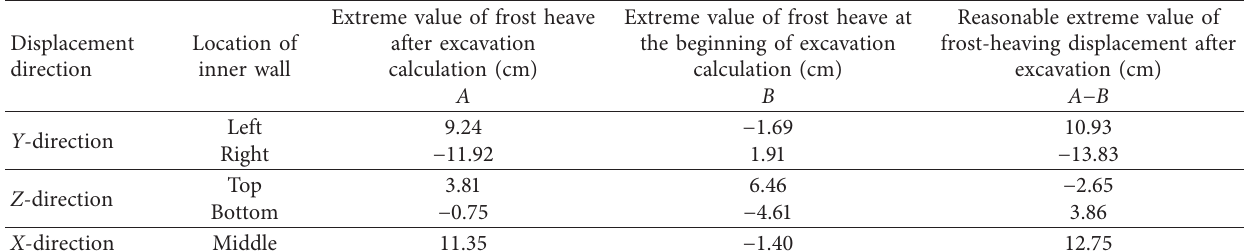
Figure 6: Nephograms of the frost-heaving displacement after the cross passage excavation displacement calculation (unit: m): (a) Y - direction, (b) Z -direction, and (c) X Table 3: Calculation of the frost-heaving displacement of the inner wall of the cross passage.